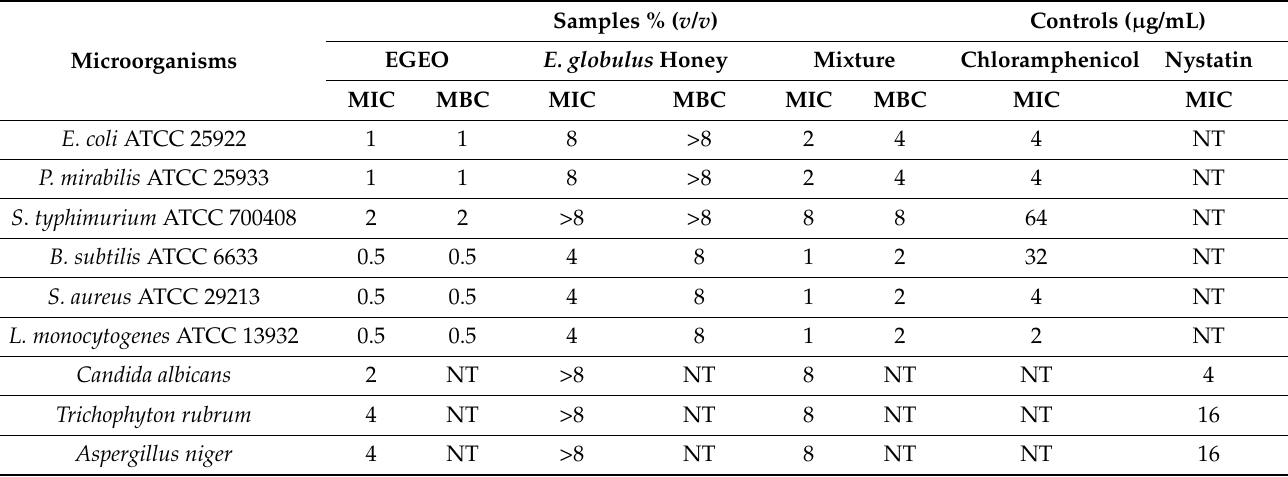
Table 7. MIC and MBC of EGEO, E. globulus honey, and their mixture in percentage ( v / v